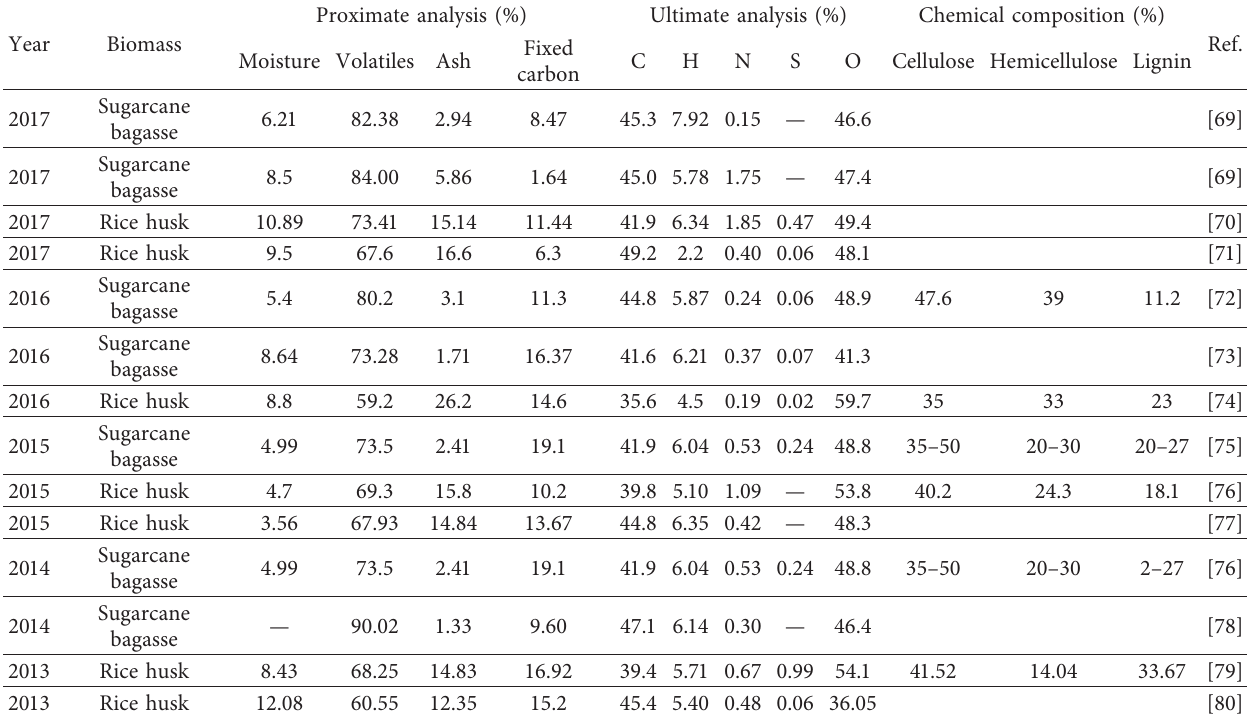
Table 2: Elemental and chemical composition of lignocellulosic